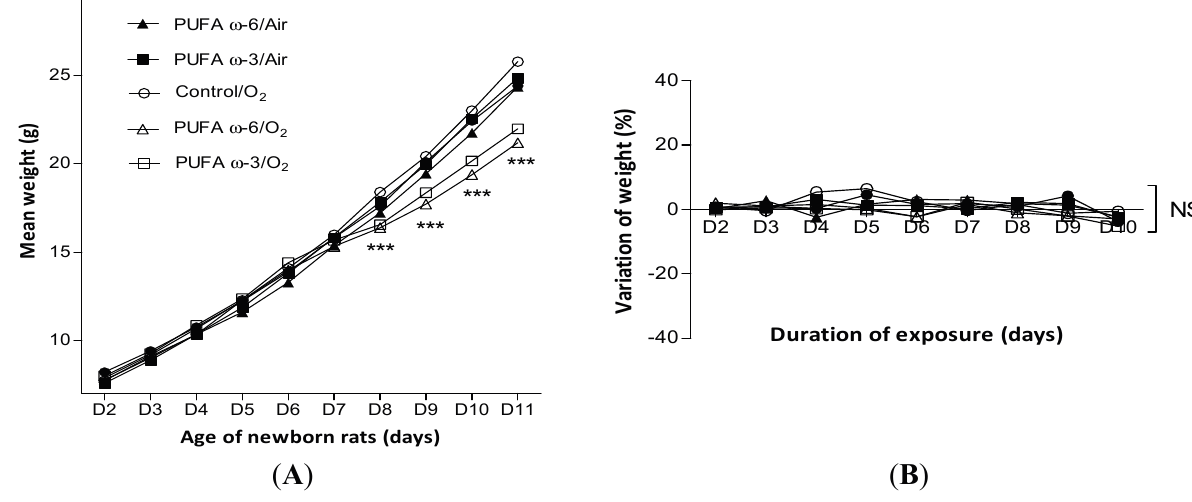
Figure 1. Evolution of weight of newborn rats ( A ) and daily variation of weight of nursing adult rats ( B ) depending on exposure to hyperoxia and type of supplementation. Value are expressed as mean ± SEM ( n = 30 in PUFA ω -6/air, PUFA ω -3/air, PUFA ω -6/O 2 and PUFA ω -3/O 2 , and n = 10 in control/air and control/O 2 ). *** p < 0.001 comparing PUFA ω -6/O 2 to control/air and to PUFA ω -6/air and comparing PUFA ω -3/O 2 to control/air and to PUFA ω -3/air (Figure 1A). NS: not